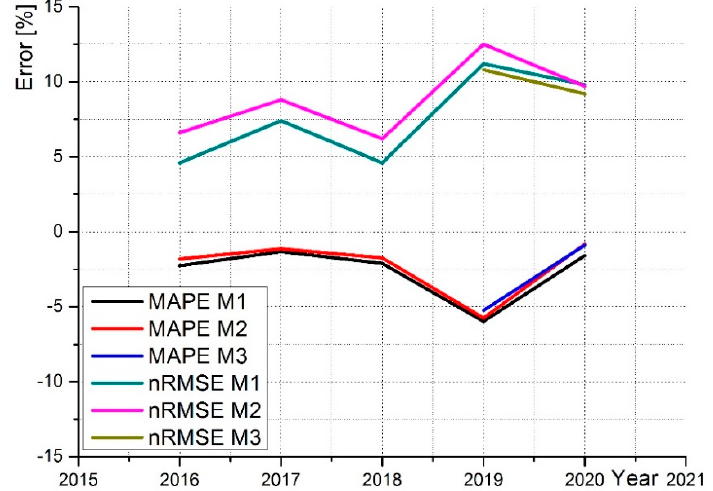
Figure 17. Evolution of nRMSE and MAPE over the years for the regression and ANN models. Table 3. Statistical and energy metrics for 2019–2020 (all three model versions).